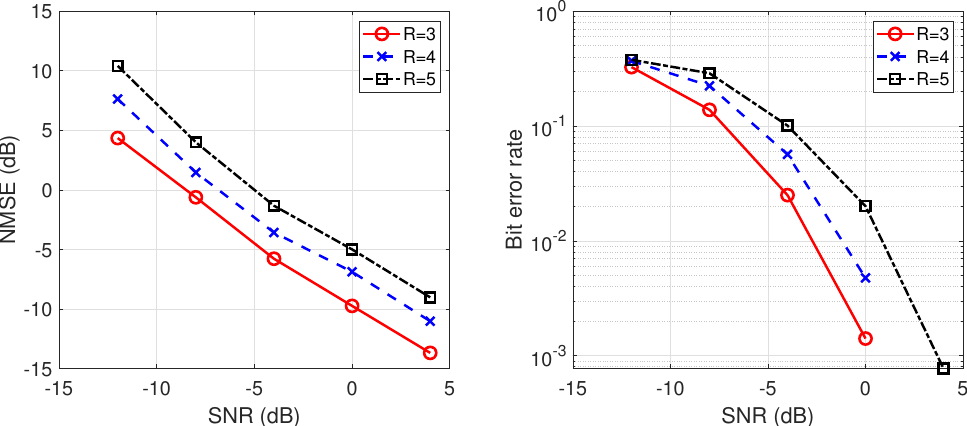
Figure 6. NMSE of estimated spreading waveform and BER of information sequence ( I = 2, L = 63, G = 30, M =